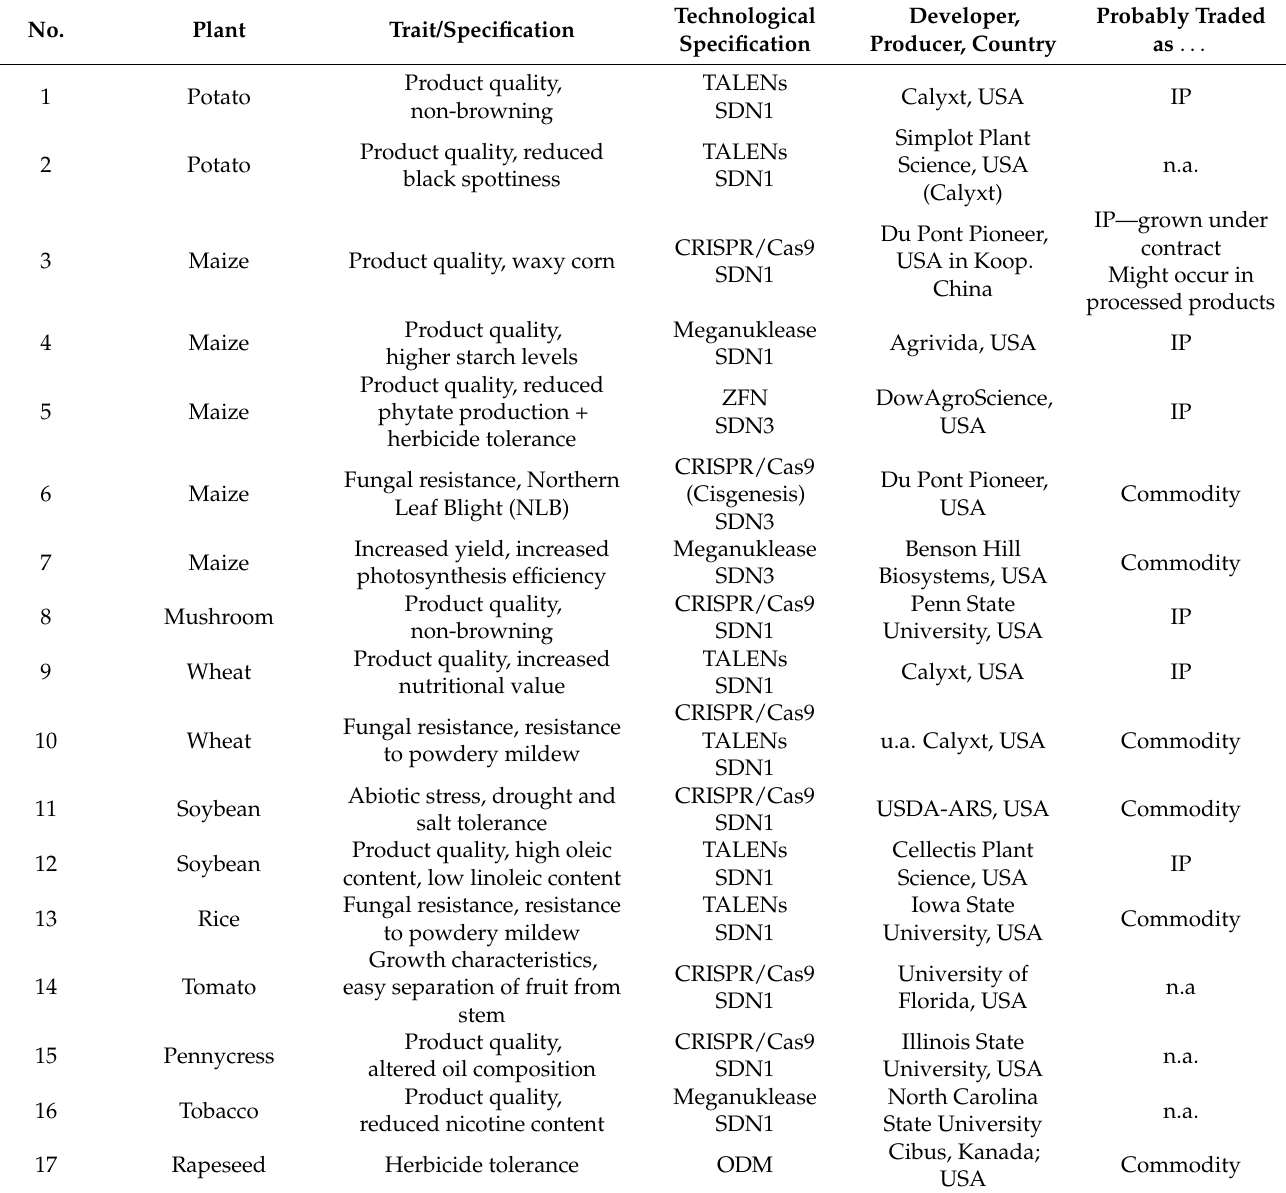
Table A1. Genome-edited plants with market-oriented traits